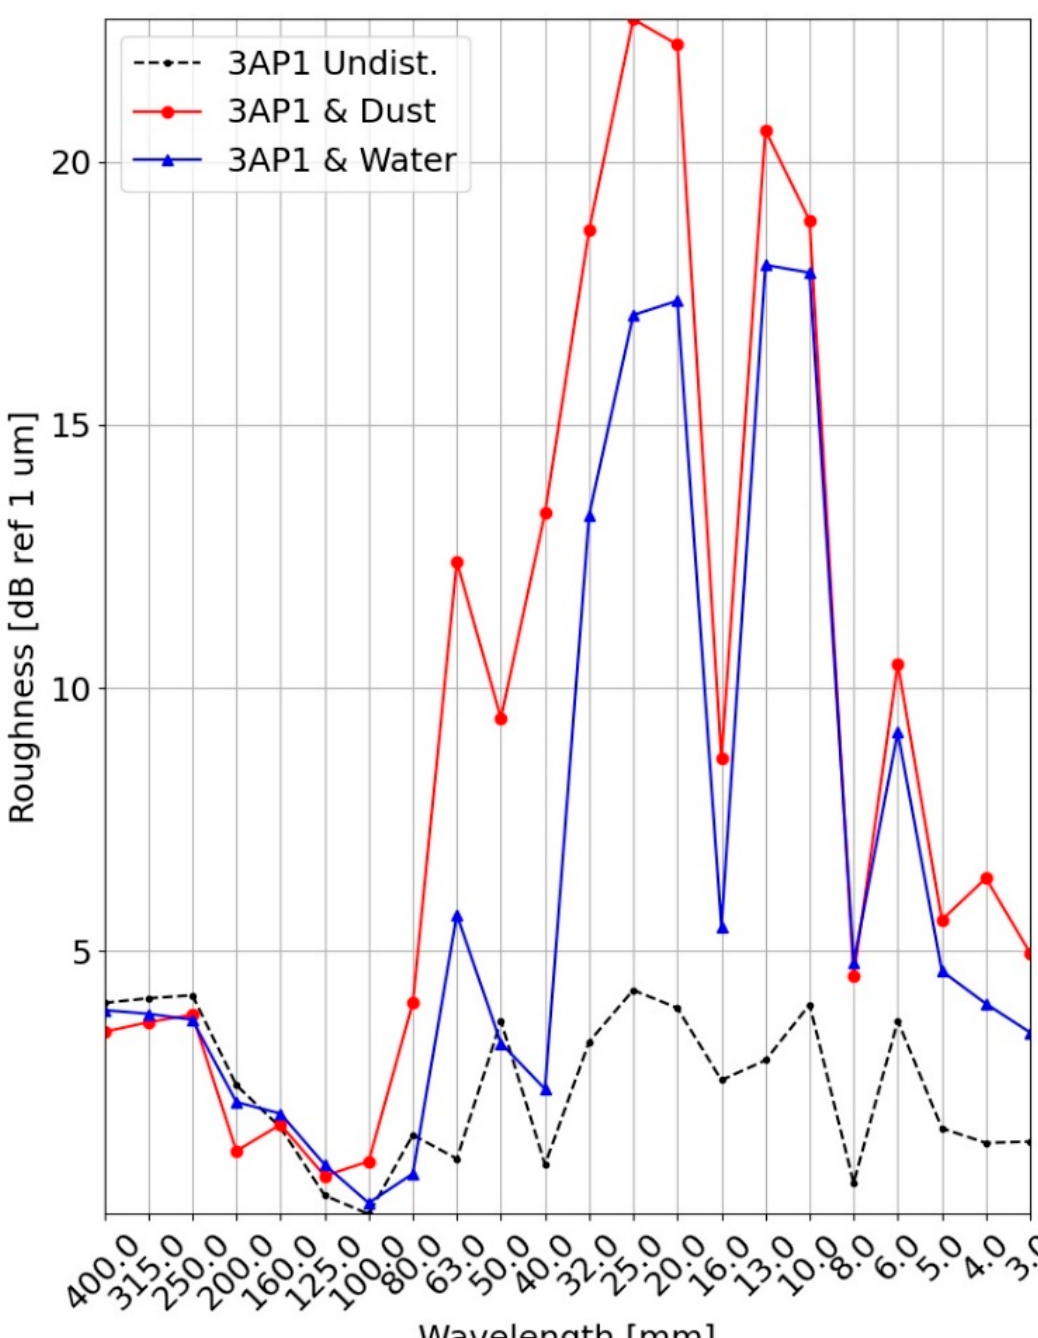
Figure 6. Absolute error of acoustic roughness for an undisturbed measurement (chord method), for a measurement with water on the rail surface and for a measurement with dust on the rail.